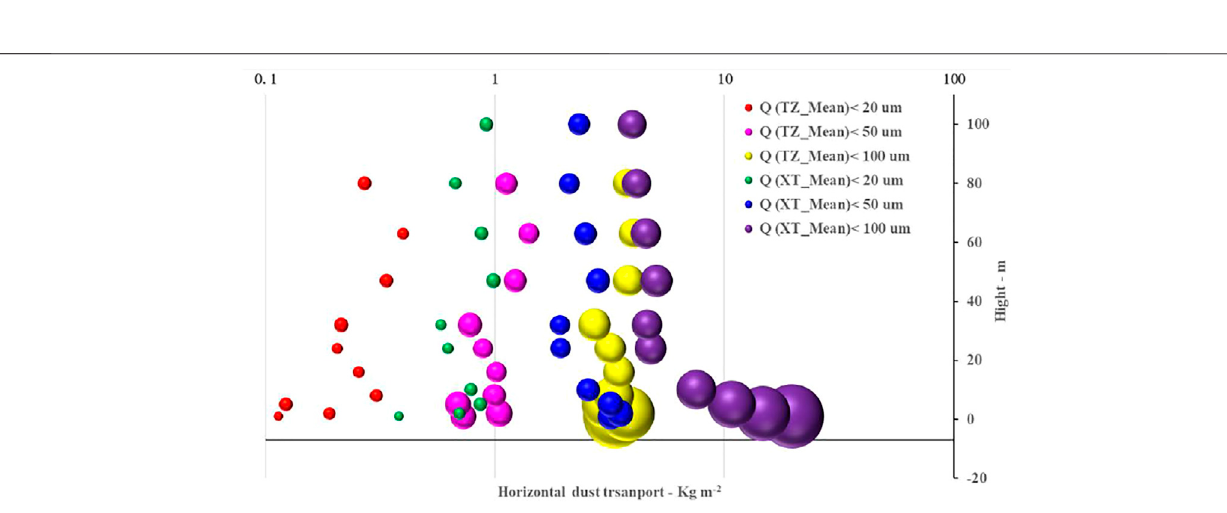
FIGURE7| Three-dimensionaldiagramofthemeanhorizontaldust fl uxes( < 20 μ m, < 50 μ m,and < 100 μ m)varyingwithheightinXTandTZ(thesizeofthespheres represents the magnitude of